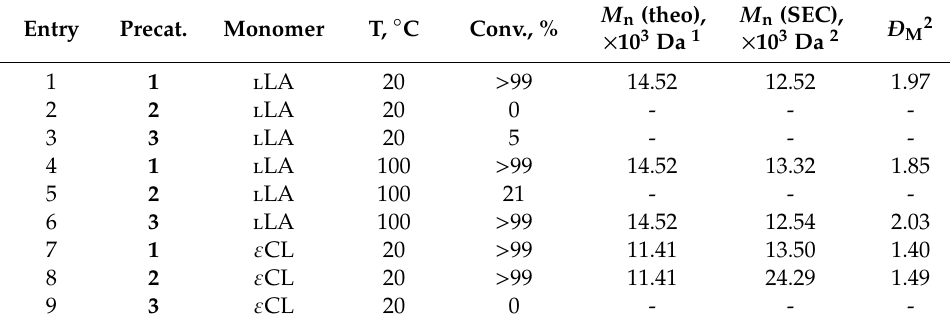
Table 1. Homopolymerization results for complexes 1 – 3 (1 M monomer solutions in